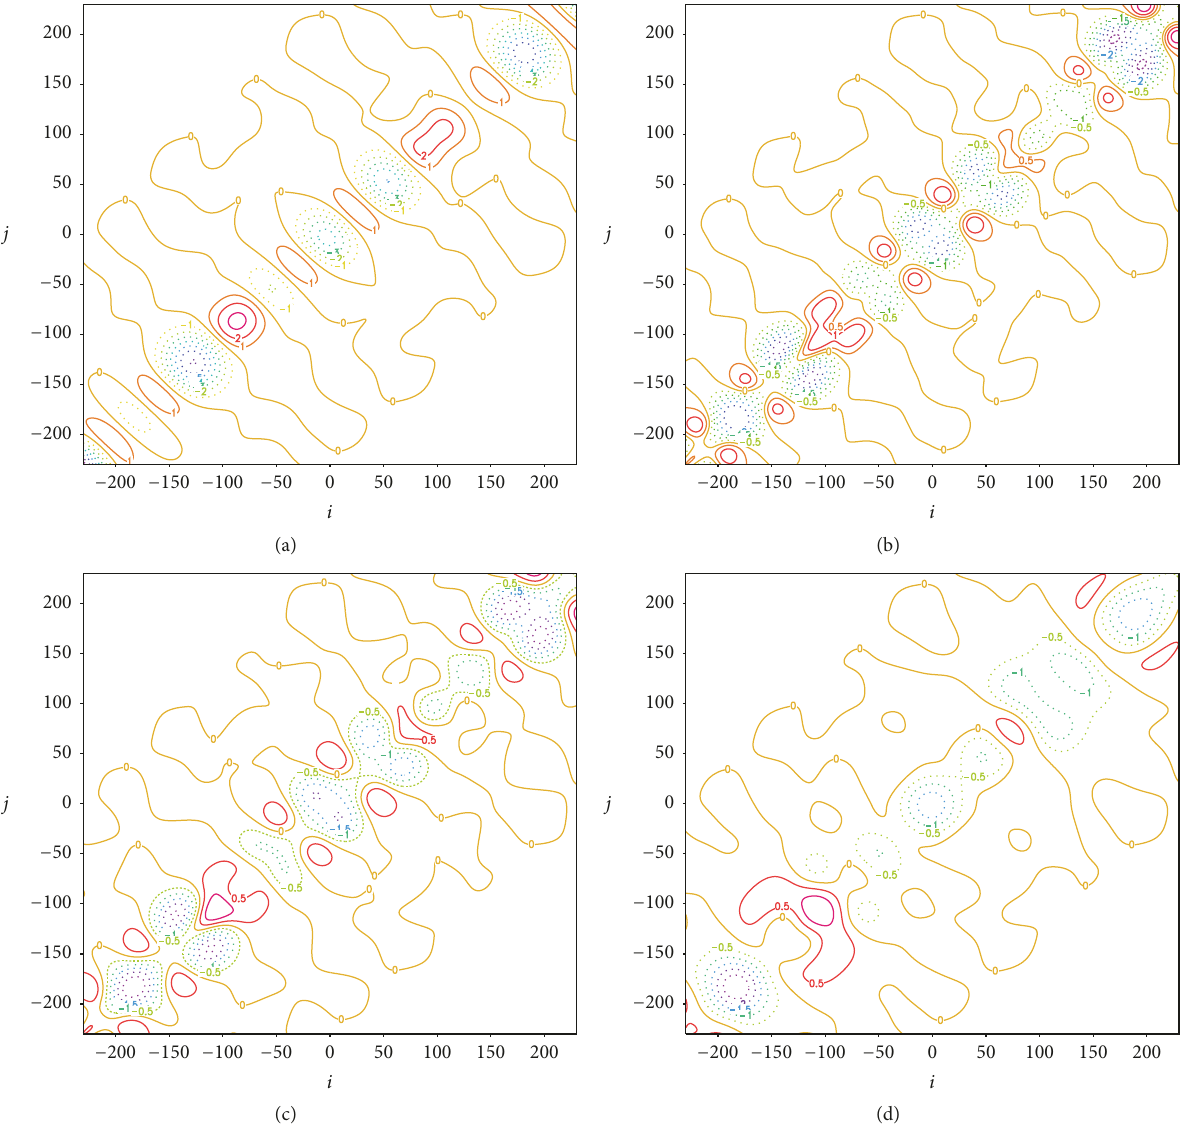
Figure 9: As in Figure 7 but for the case in Figure